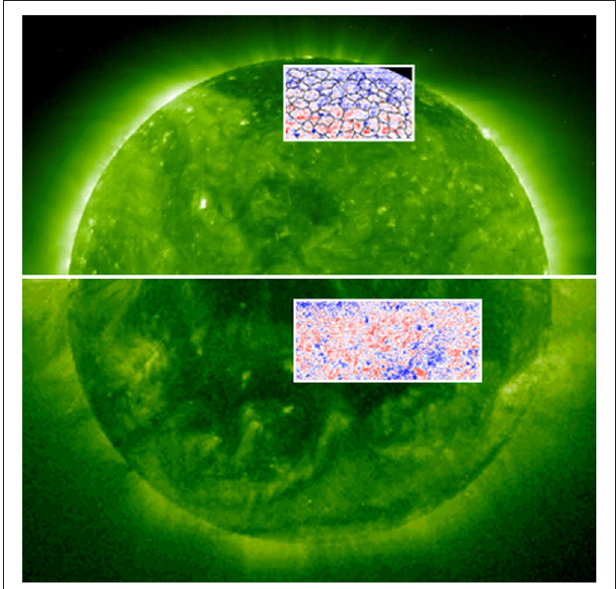
FIGURE 3 | Line-of-sight velocity structures observed by the SUMER instrument on SOHO show correlation of outflow velocity with chromospheric network structure within coronal holes both at mid-latitudes (bottom) and at high latitudes (top) ( Hassler et al., 1999). As can be seen in the figure, observations of the detailed structure of solar wind outflow at the poles is made difficult by foreshortening, and would be significantly improved by out-of-the-ecliptic